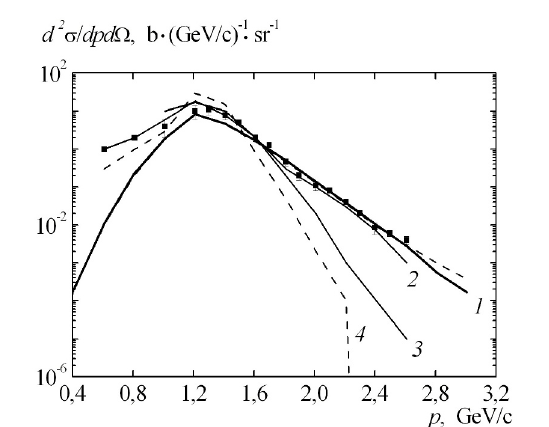
Figure 4. The same that in Fig. 3 with the 12 C ion energy of 600 MeV / nucleon, and < T h > ≈ 42.5 MeV, < µ T > ≈ -17.7